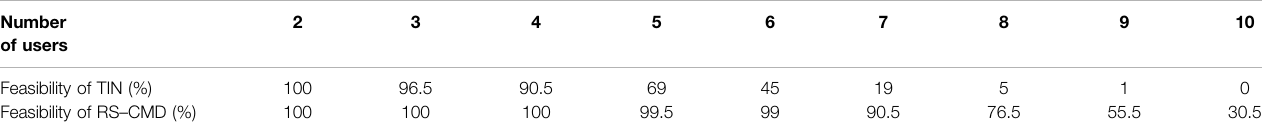
TABLE 1 | Percentage of feasible instances of the optimization problem (P 2 ) when deploying TIN and RS – CMD transmission strategies.